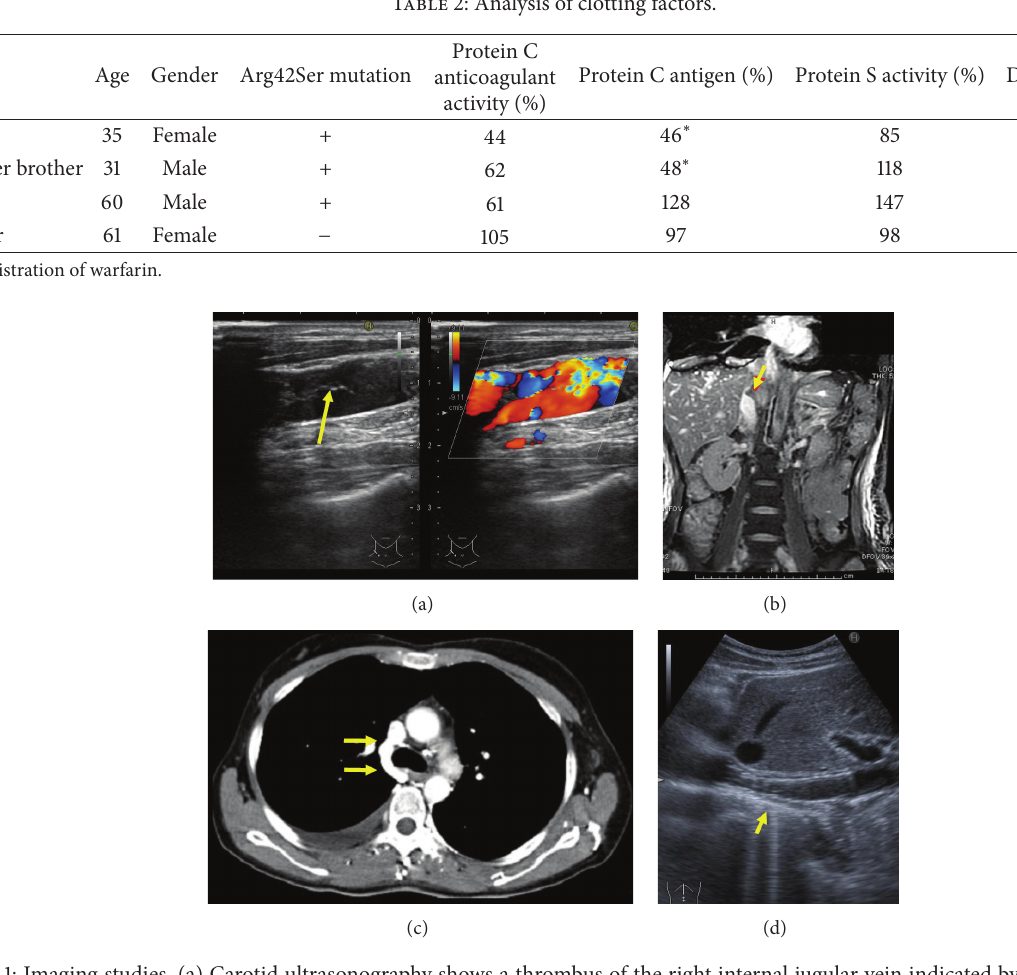
Figure 1: Imaging studies. (a) Carotid ultrasonography shows a thrombus of the right internal jugular vein indicated by the arrow. Blood flow in the right internal jugular vein was maintained. (b) Abdominal MRI first imaging employing steady state acuisition (FIESTA) reveals a high-intensity signal emanating from the intrahepatic portion of the inferior vena cava (arrow), which suggested thrombus. (c) Thoracic CT during injection of contrast medium reveals right pleural effusion and dilatation of an azygos vein at the arrows. (d) Abdominal Doppler ultrasonography shows complete patency (arrow) and no ectopia of the stent. This image was acquired 16 months after the patient was